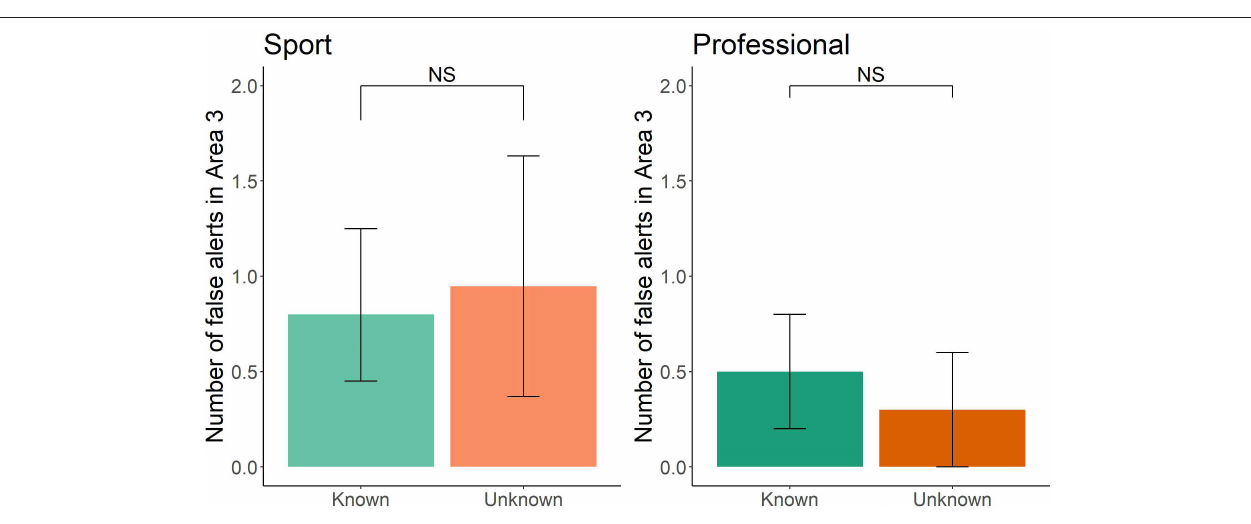
(e.g., false positive, false negative and true positives).